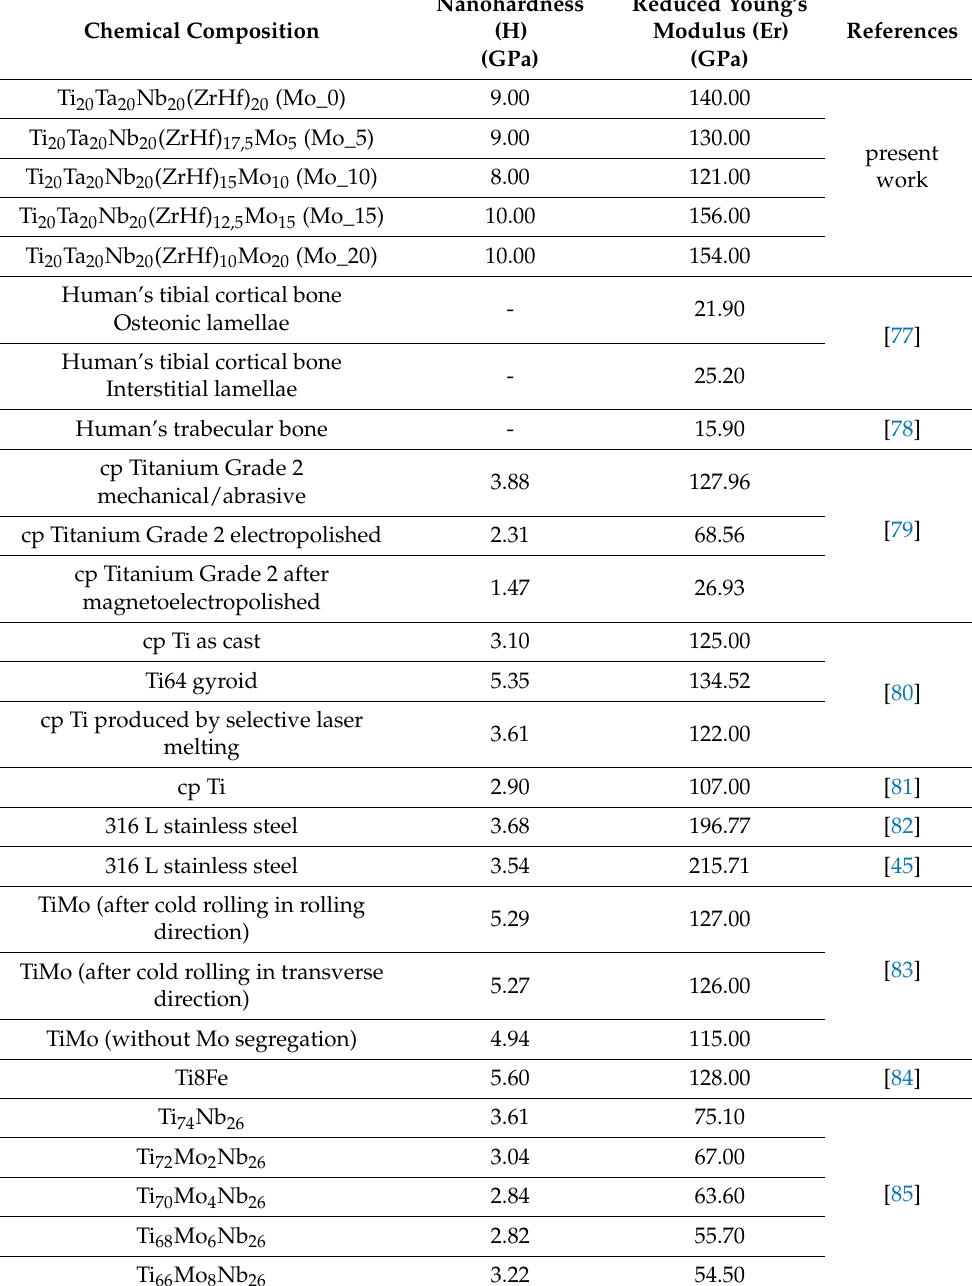
Table 7. Comparison of nanohardness and reduced Young’s modulus for all studied alloys and literature-reported conventional biomedical materials and biomedical high entropy alloys.